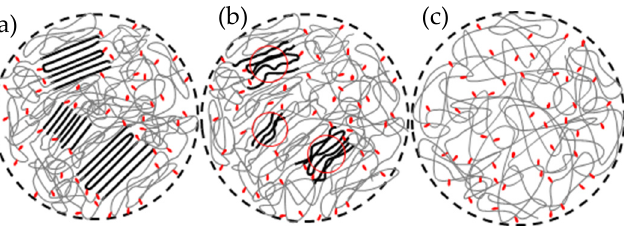
Figure 2. Schematics of ( a ) random copolymer semicrystalline structure with co-units (red dots) excluded from the crystalline regions; ( b ) heterogeneous, non-equilibrated melt with crystalline memory: ( c ) homogeneous equilibrated melt. Adapted with permission from Reference [10]. Copyright (2013) American Chemical Society.